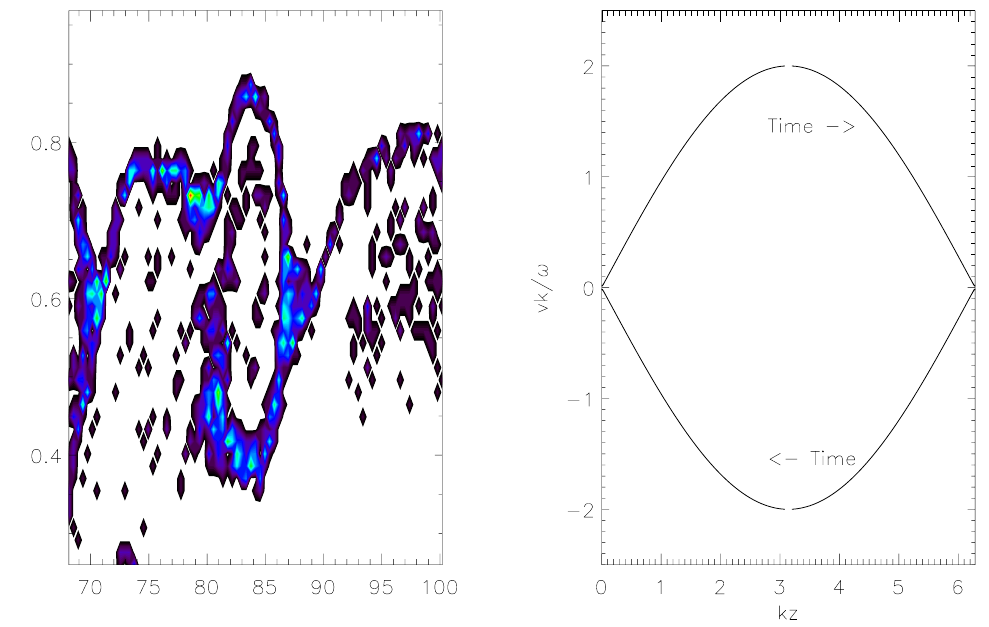
Fig. 9. (Left) zoom on the electron hole observed in the large amplitude case at ω pe t = 640 (see Fig. 8), and (right) analytical solution of electron hole from a simple model (see Appendix for